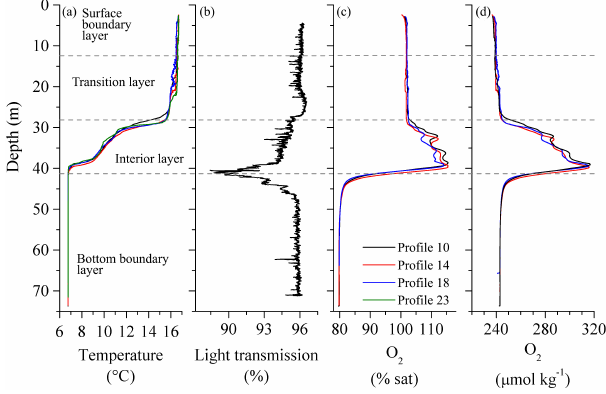
Figure 2. Water column profiles based on high-resolution MSS pro- files (a, c, d) and ship CTD profile (b) . (a) Potential temperature profiles. Water column layers were identified based on the temper- ature profiles. A 0.2 and 1.5 ◦ C decrease from the surface boundary layer average temperature (3–6m depth) was used determine the depth of the surface boundary layer to the transition layer interface and the transition layer to the interior layer interface, respectively. Correspondingly, a 0.2 ◦ C from a 50–60m depth average tempera- ture was used to locate the interior layer to the BBL interface. (b) Light transmission profile. (c, d) O 2 saturation profiles and associ- ated absolute concentrations.